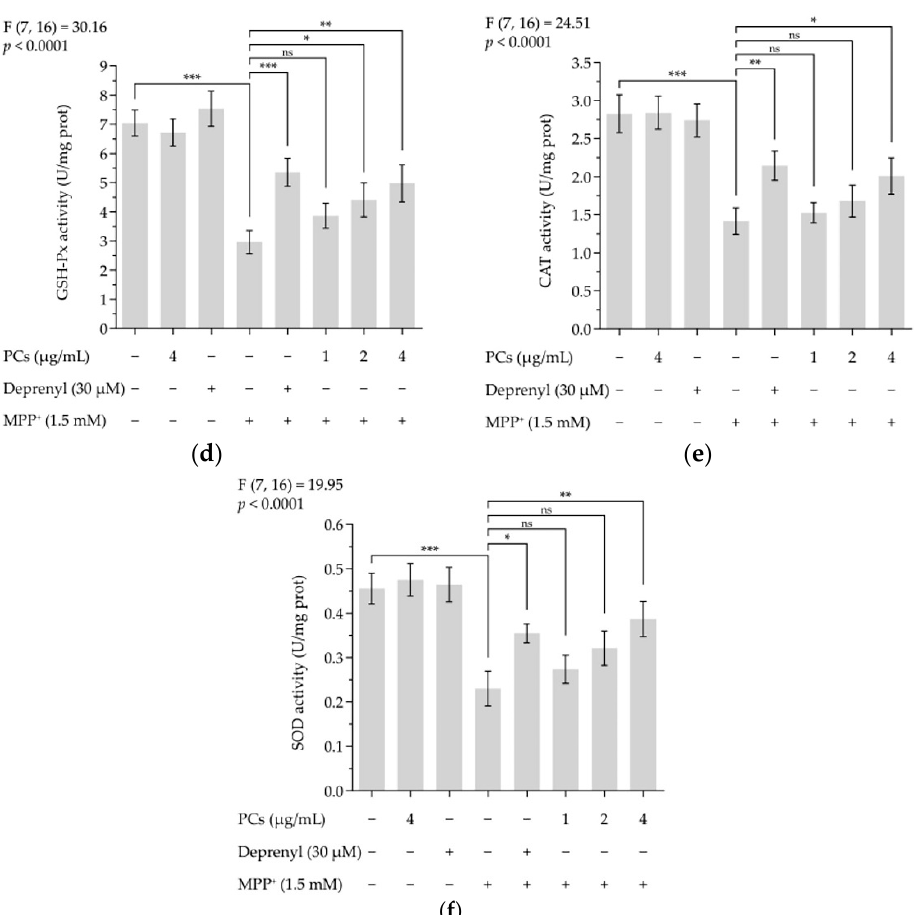
Figure 2. PCs reduced MPP + -induced oxidative stress and increased antioxidant enzyme activity. ( a ) ROS levels were measured by fluorescent microscopy and imaging analysis; ( b ) ROS levels were measured by image J software; ( c ) MDA levels; ( d ) GSH-Px activity; ( e ) CAT activity; ( f ) SOD activity. F and p values of the one-way analysis of variance are presented above each chart. The results of Tukey’s post hoc test are presented for selected comparisons: ns, p > 0.05; *, p < 0.05; **, p < 0.01; ***, p < 0.001; the error bars are SD.